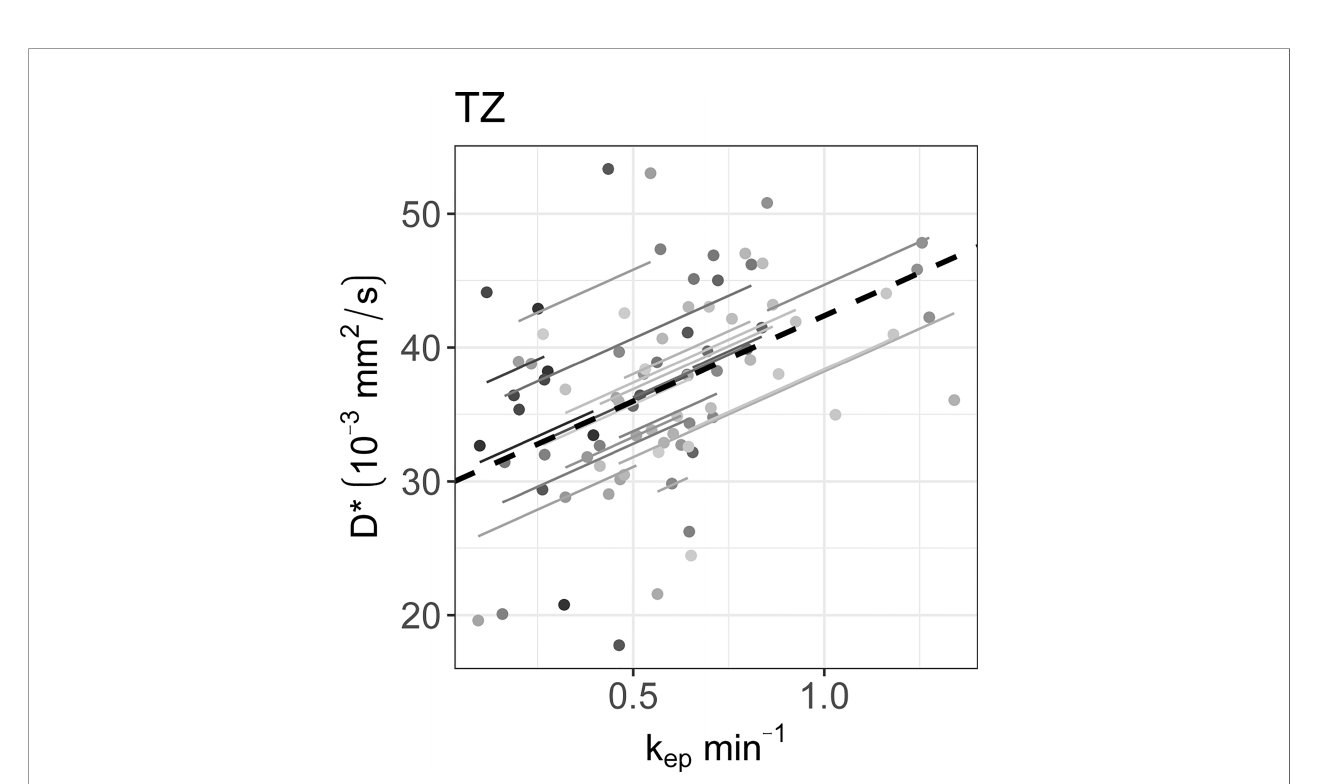
FIGURE 5 | The signi fi cant repeated measures correlations of D* with the DCE parameters are shown. D* only correlated signi fi cantly with k ep in the TZ. Each line shows the fi t for a single patient and the dashed black line shows the overall common